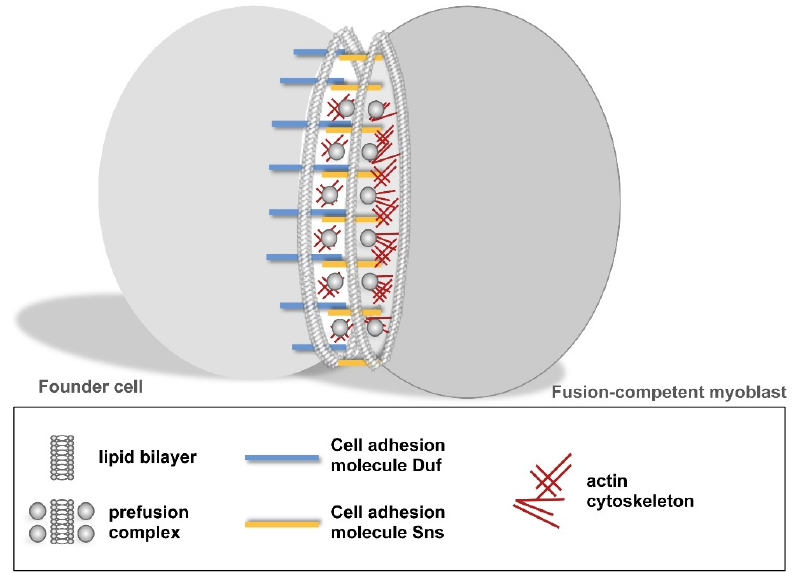
Figure 3. Formation of a cell–cell communication structure. The recognition and adhesion of myoblasts is established by Duf–Sns interactions. This process triggers a protein-machinery that leads to the recruitment of electron-dense vesicles and F-actin polymerization at the apposing membranes.